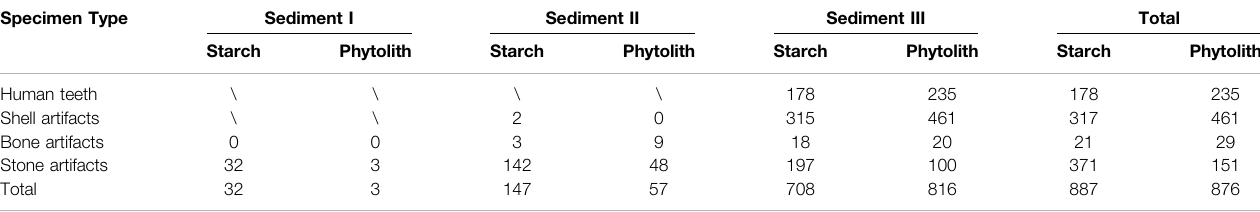
TABLE 1 | Frequency of plant microfossil remains at the Dingsishan